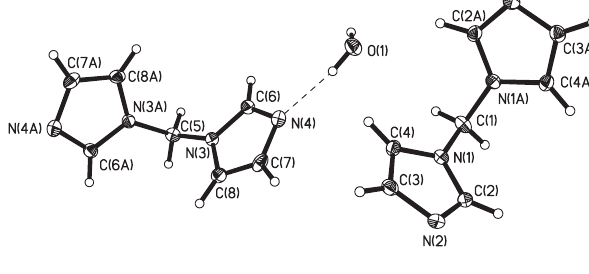
Table 1: Data collection and handling.